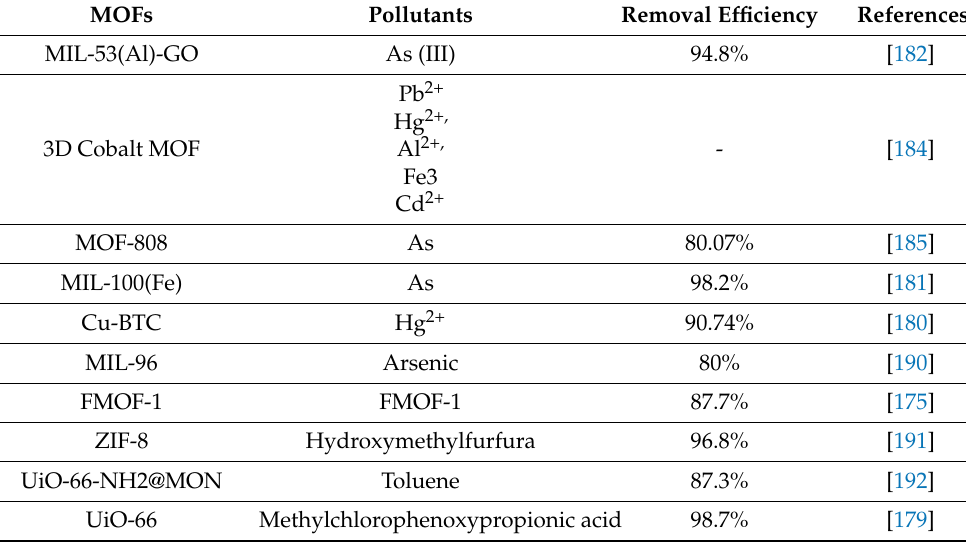
Table 7. Metal–organic framework for wastewater